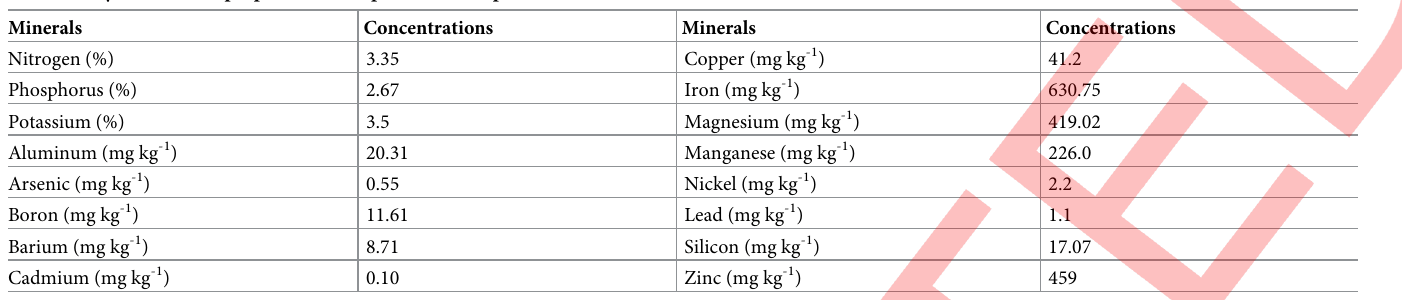
Table 1. Physicochemical properties of compost used in